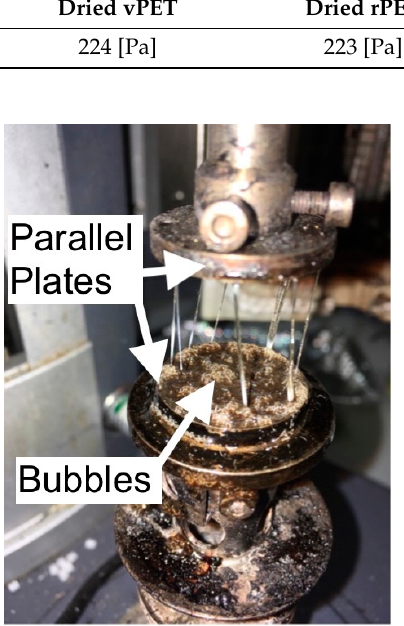
Figure 8. Degraded rPET after relaxation test.